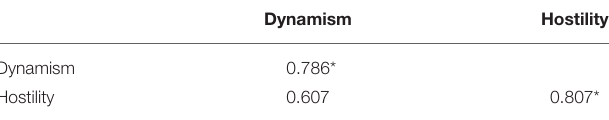
TABLE 5 | Discriminant validity environment.